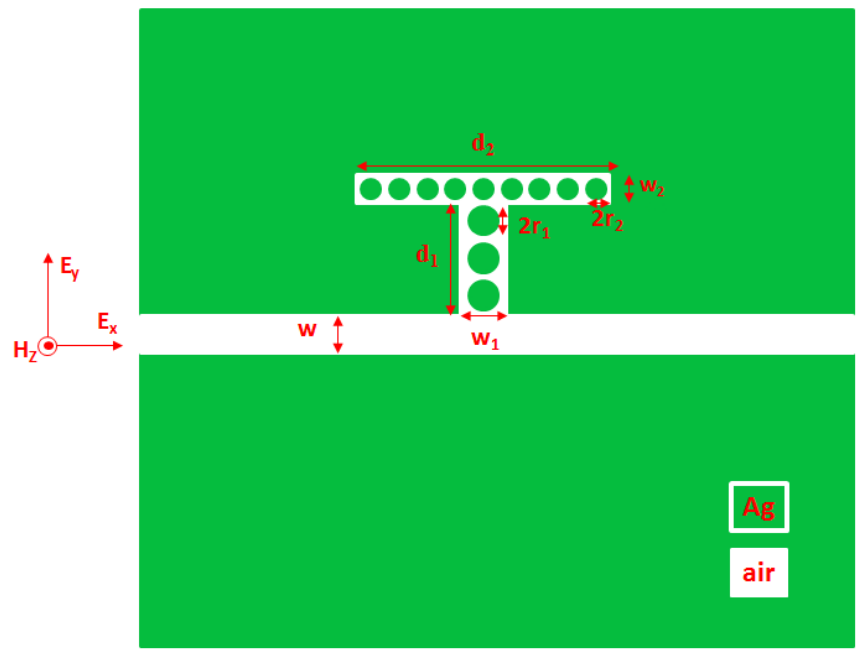
Figure 1. Schematic diagram of the proposed metal–insulator–metal (MIM) sensor structure coupled with several silver nanorod defects in a T-shape cavity.